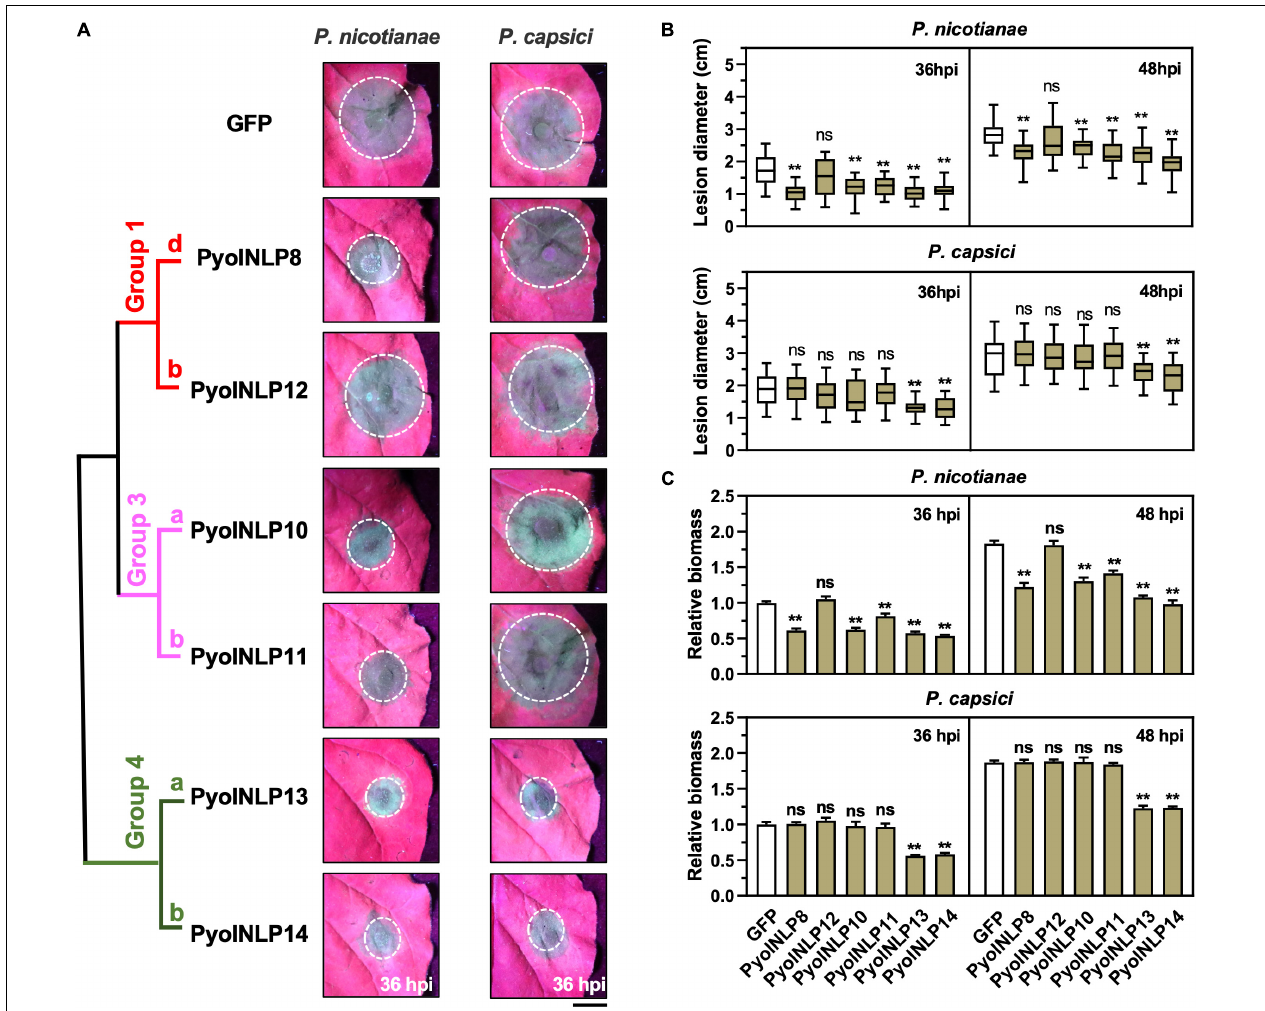
FIGURE 4 | Non-cytotoxic PyolNLPs are able to suppress Phytophthora infection in N. benthamiana . (A) Infection phenotypes of agroinfiltrated N. benthamiana leaves expressing GFP, PyolNLP8, PyolNLP10, PyolNLP11, PyolNLP12, PyolNLP13 or PyolNLP14, and followed by the inoculation of P. nicotianae or P. capsici . Photos were taken at 36 hpi (Scale bar, 1 cm). GFP was used as a negative control. (B) Lesion diameters were measured using ImageJ. Data were analyzed from at least 40 biological replicates. Error bar represents mean ± SD. (C) Relative biomass was determined by qPCR. Expression levels of P. nicotianae and P. capsici Actin were determined by qPCR using N. benthamiana EF1 α as reference. Error bar represents mean ± SD ( n = 3). Data were analyzed by Median-edition Levene’s test to determine the homogeneity of variance across groups, and then analyzed by one-way ANOVA with post-hoc Tukey’s range test for groups with equal variance, or Kruskal-Wallis test analysis for groups with unequal variance (ns, no significant difference; ** P < 0.01). All experiments were repeated at least three times.